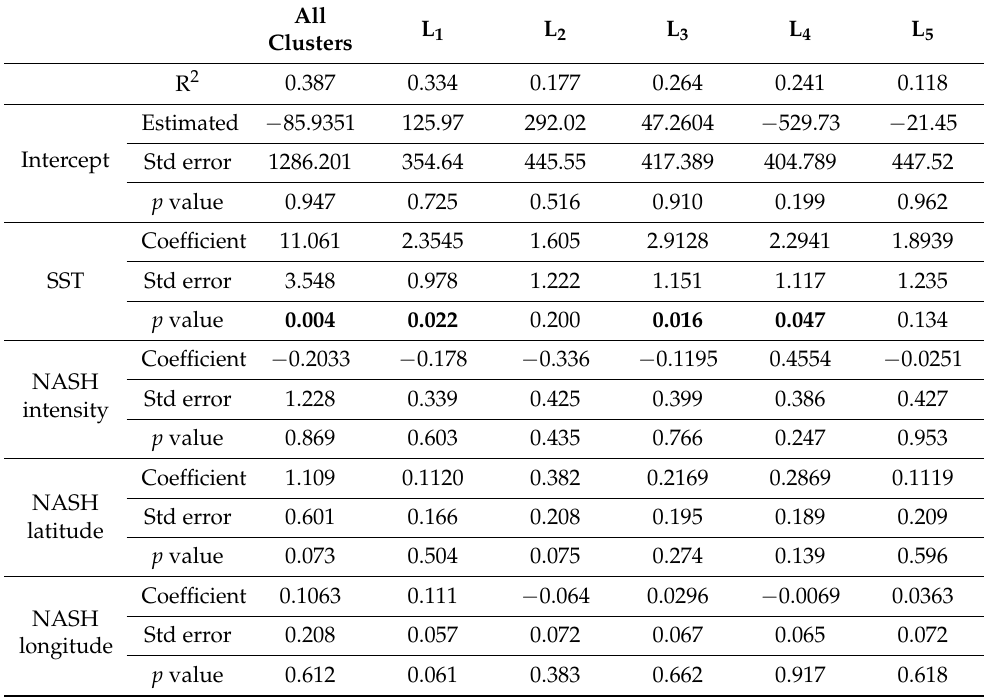
Table 4. Generalized least squares (GLS) multiple linear regression of annual NATL landfalling frequency (for the whole basin and each cluster) onto the SST and NASH (intensity and position). The SST and NASH values are based on June–November. Statistical significance is marked with the bold text ( p < 0.05). SST is in ◦ C and NASH intensity in hPa. NASH latitude and NASH longitude represent the NASH center latitude and NASH center longitude,